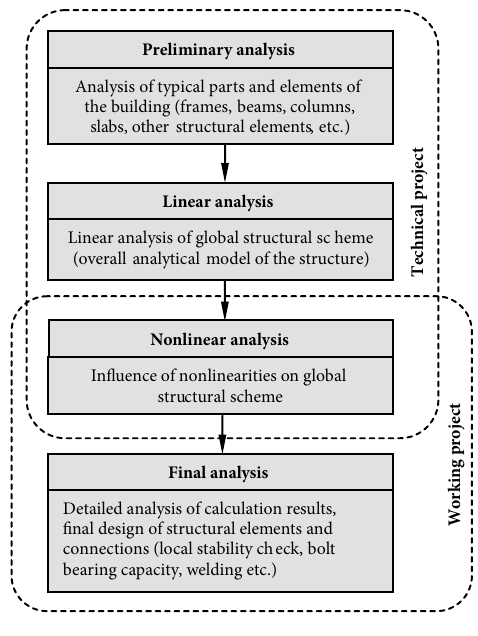
Fig. 7. Structural analysis in different stages of the project